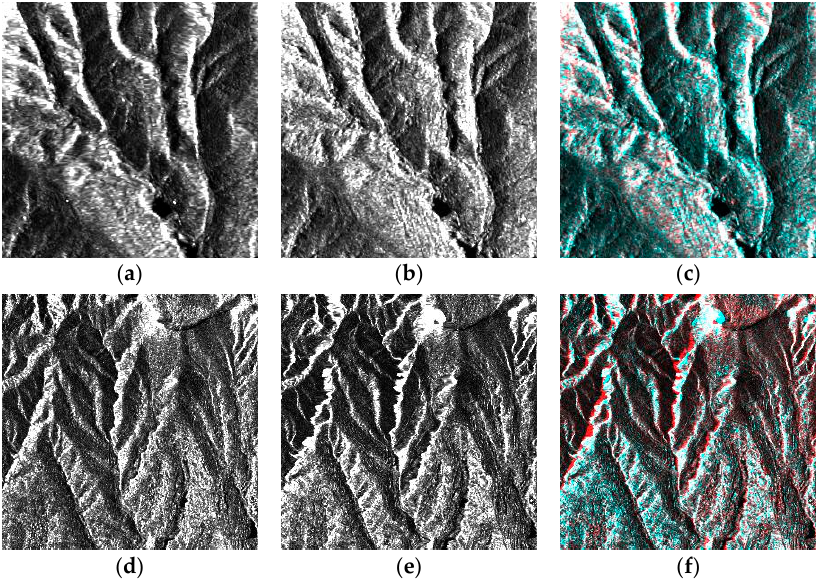
Figure 3. Zoomed region in ( a ) left and ( b ) right Spotlight epipolar image and ( c ) the stereo anaglyph. Zoomed region in ( d ) left and ( e ) right Stripmap epipolar image and ( f ) the stereo anaglyph.